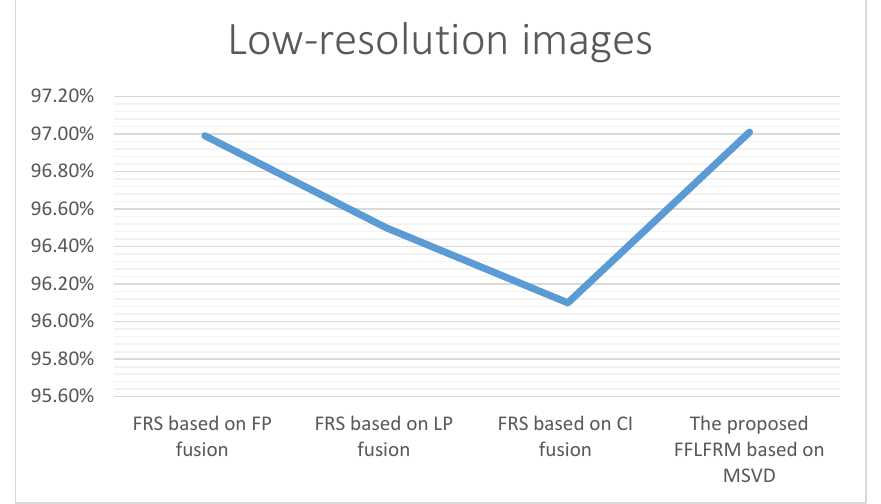
Fig. 7. Recognition accuracies of the four studied FRSs under the condition of low image